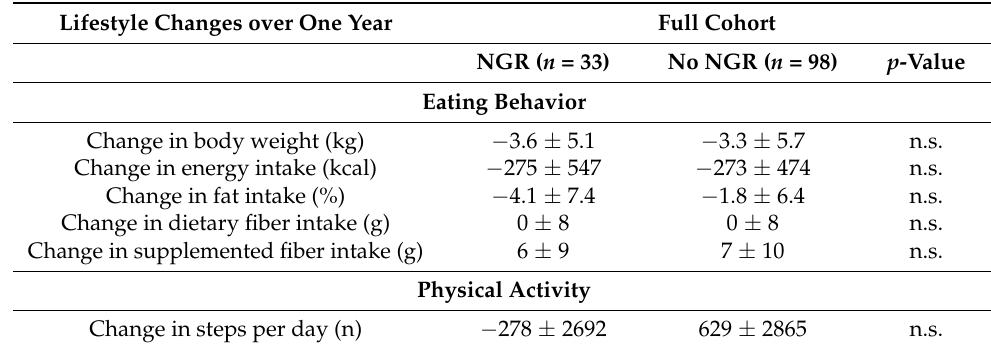
Table 2. Changes in lifestyle parameters during the one-year PREDIAS intervention; Mann–Whitney tests for comparison of NGR and non-NGR subgroups.